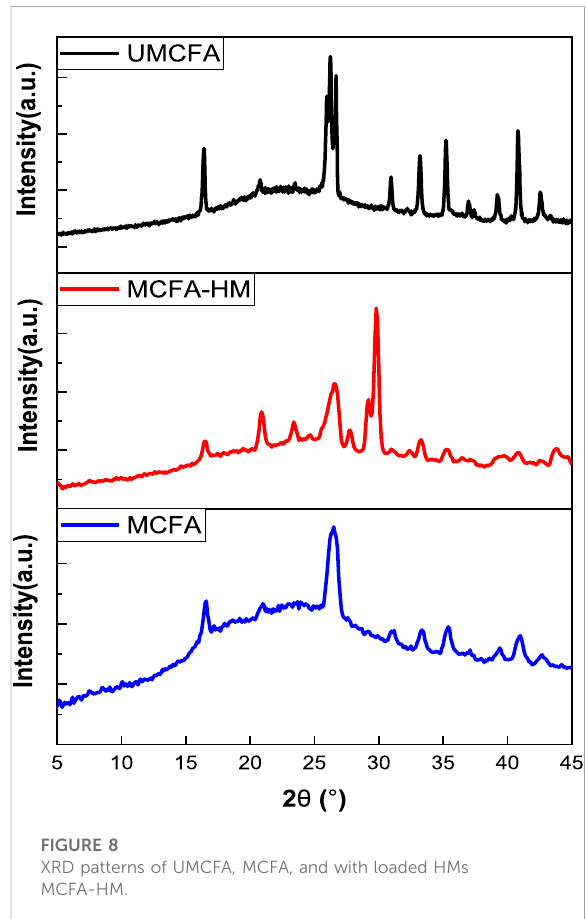
FIGURE 8 XRD patterns of UMCFA, MCFA, and with loaded HMs MCFA-HM.